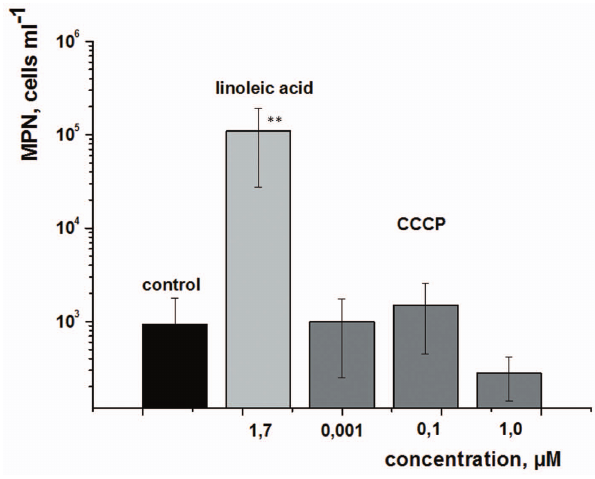
Figure 5. Intracellular cAMP levels and 3 H-uracil incorporation during oleic acid-induced resuscitation of M. smegmatis NC cells. NC cells were obtained and resuscitated in batch mode. Oleic acid was added at a concentration of 3.5 m M. The intracellular level of cAMP was estimated after cells had been harvested and disrupted as described in the Materials and Methods. For samples taken during the first 48 h of resuscitation, metabolic activity was determined using 3 H- uracil incorporation (denoted CPM on the Figure axis) as detailed in Materials and Methods. Dotted lines divide the overall process into three phases: 0 - true lag, I - metabolic activation, II - cell multiplication. This experiment was repeated three times with similar results. Error bars represent the standard error of the mean. Asterisks indicate that the results are significantly different from the values at zero time by Student’s